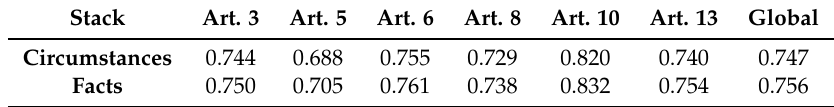
Table 11. Individual and global accuracies for the stack dataset (Attention + binary + PLS